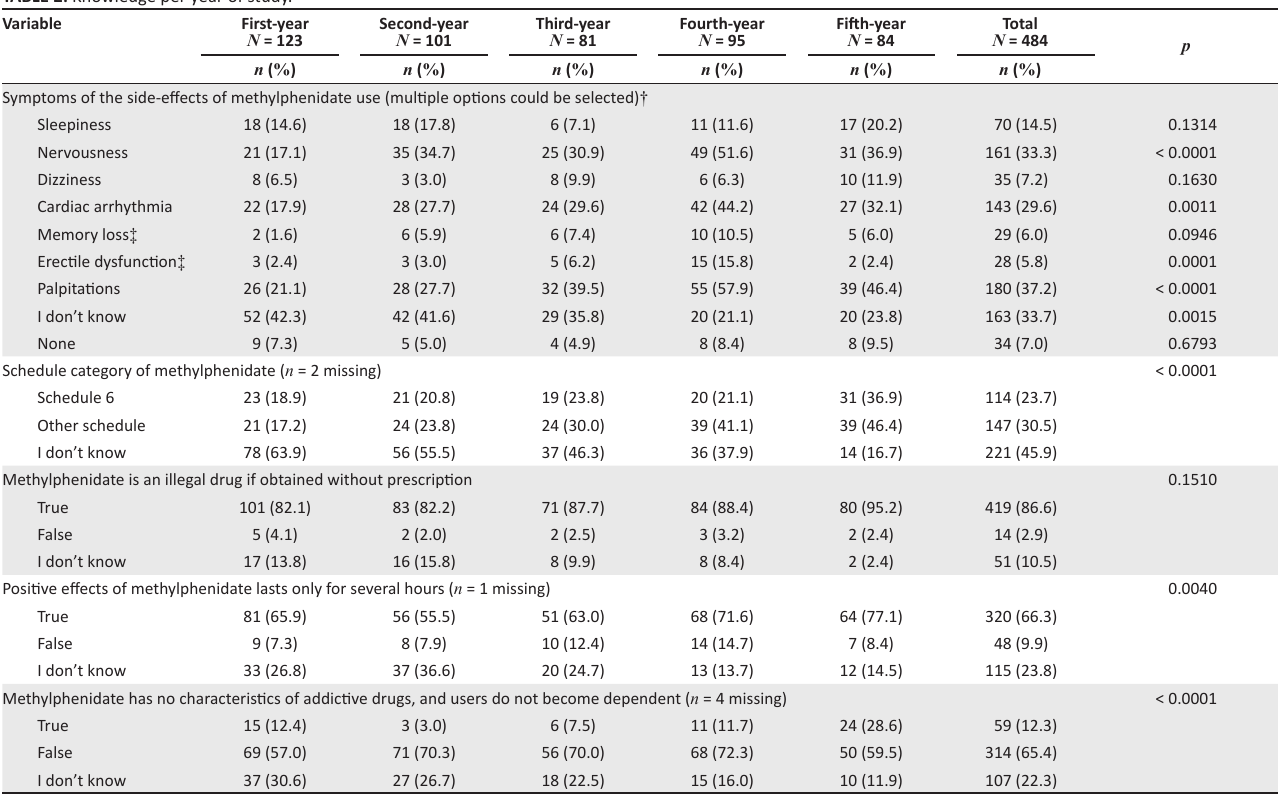
TABLE 2: Knowledge per year of